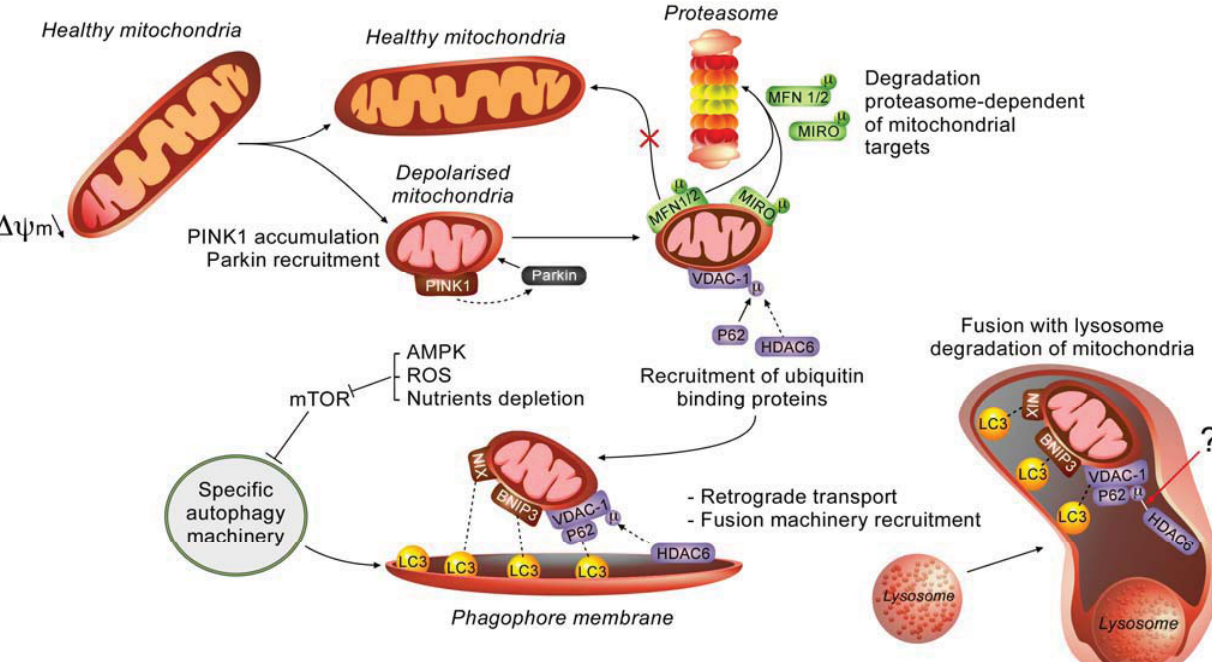
Figure 1. Mechanisms involved in